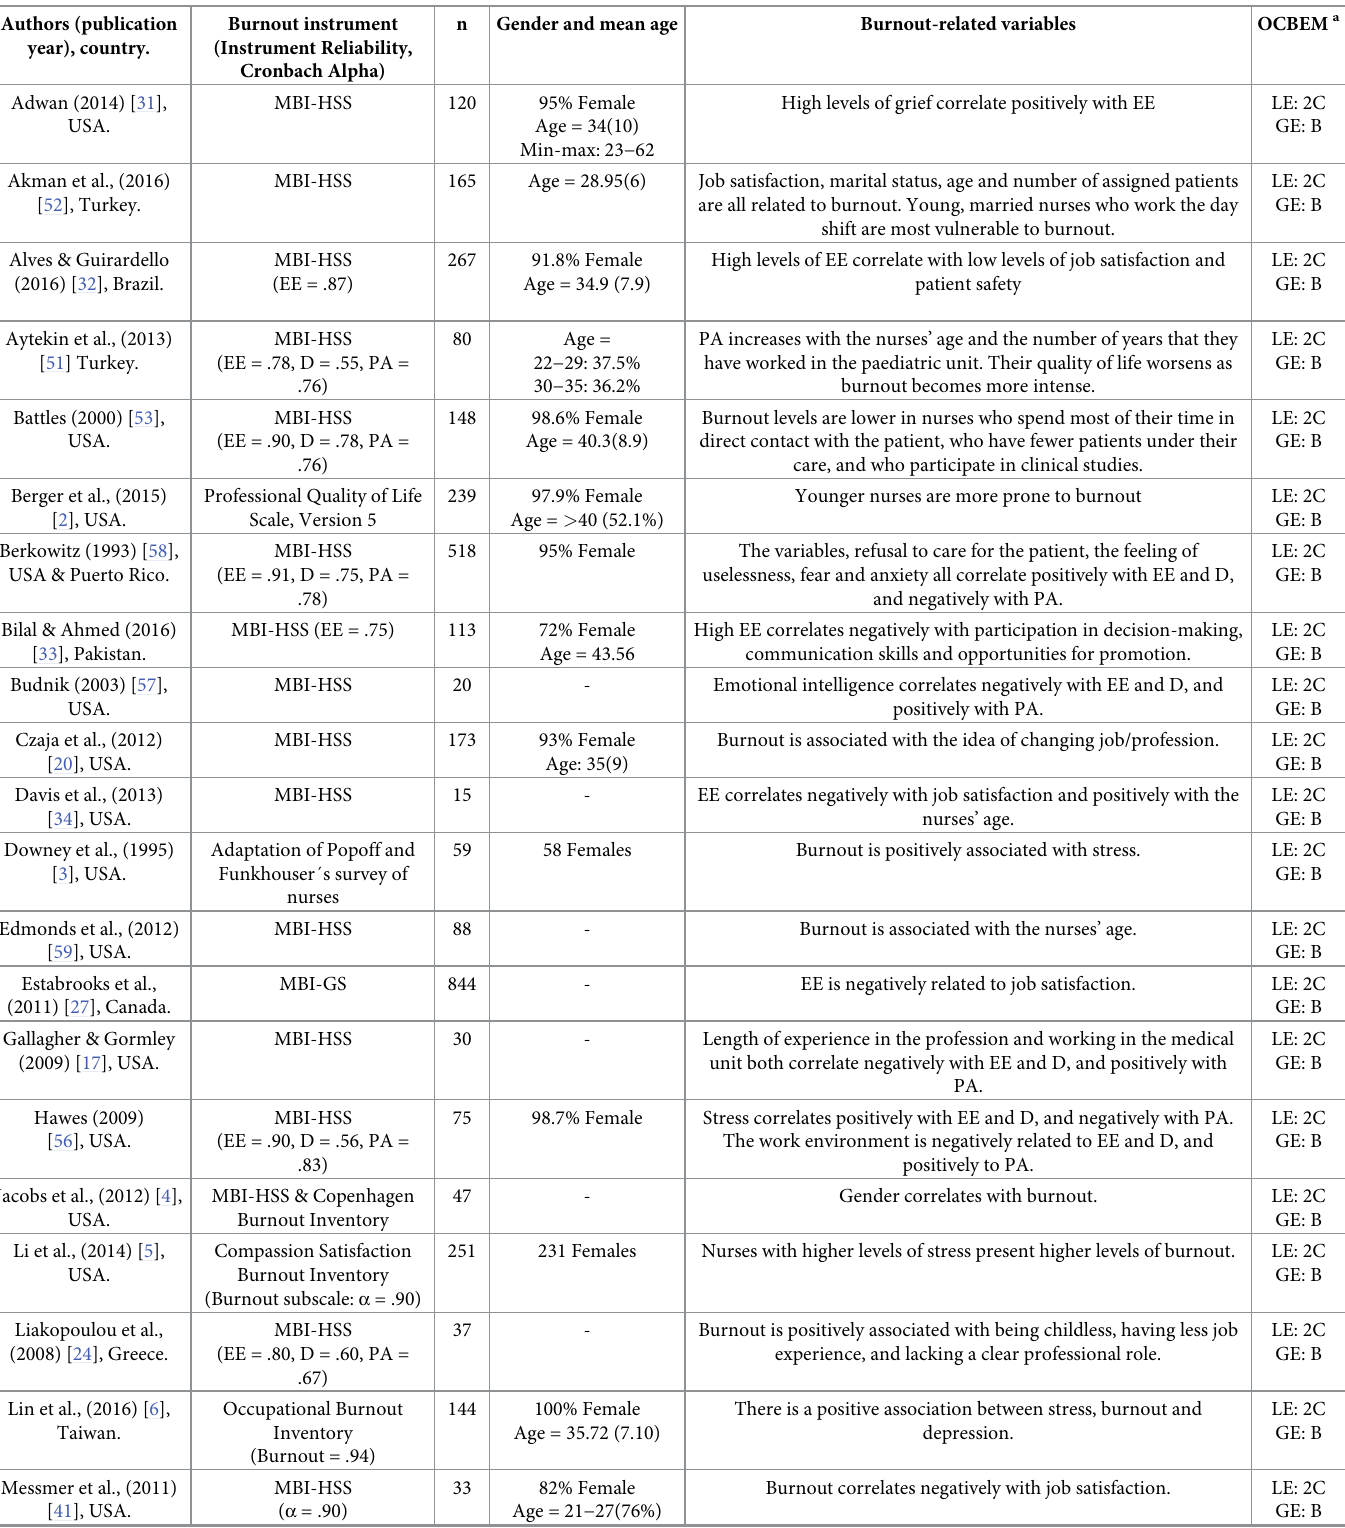
Table 1. Main results of the studies included in the review. Authors (publication year),